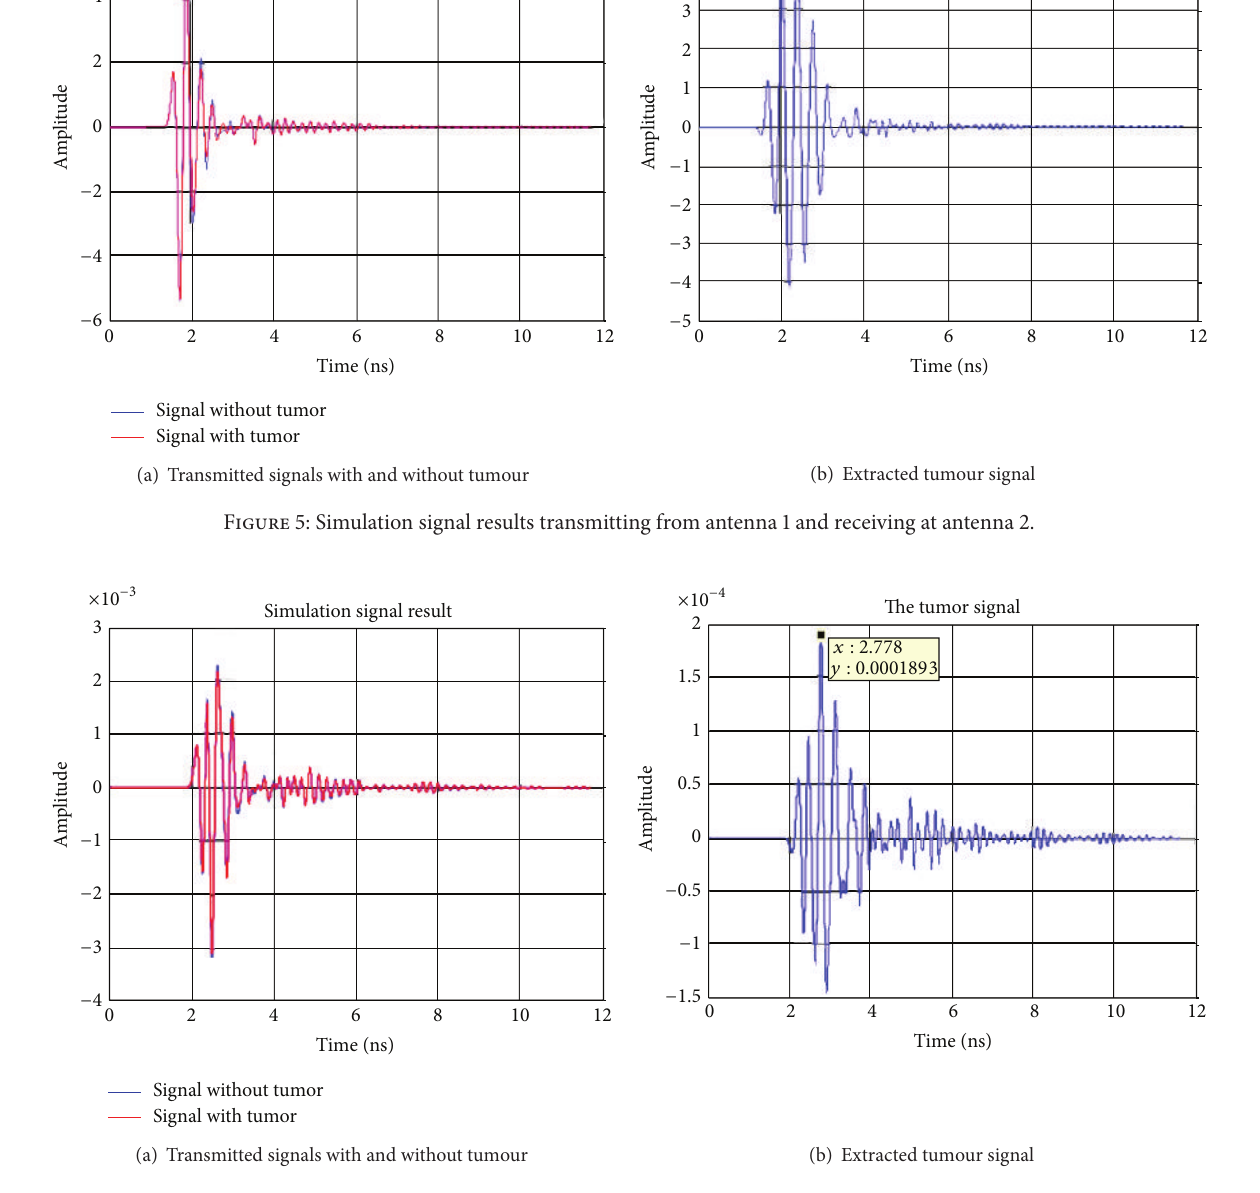
of electrical properties) or glandular organ and vasculature structures for ease of modelling and imaging. As shown in Figure 2, four horn antennas encircling the breast at equal heights are used to transmit and receive the microwave sig- nals. The aperture centre of antenna 1 is located at −55, 0, 10 , aperture centre of antenna 2 is located at 0, −55, 10 , aperture centre of antenna 3 is located at 55, 0, 10 , and aperture centre of antenna 4 is located at 0, 55, 10 . The background material should be set as a coupling medium with 𝜀 𝑟 = 9 to ensure electrical matching between antenna and internal